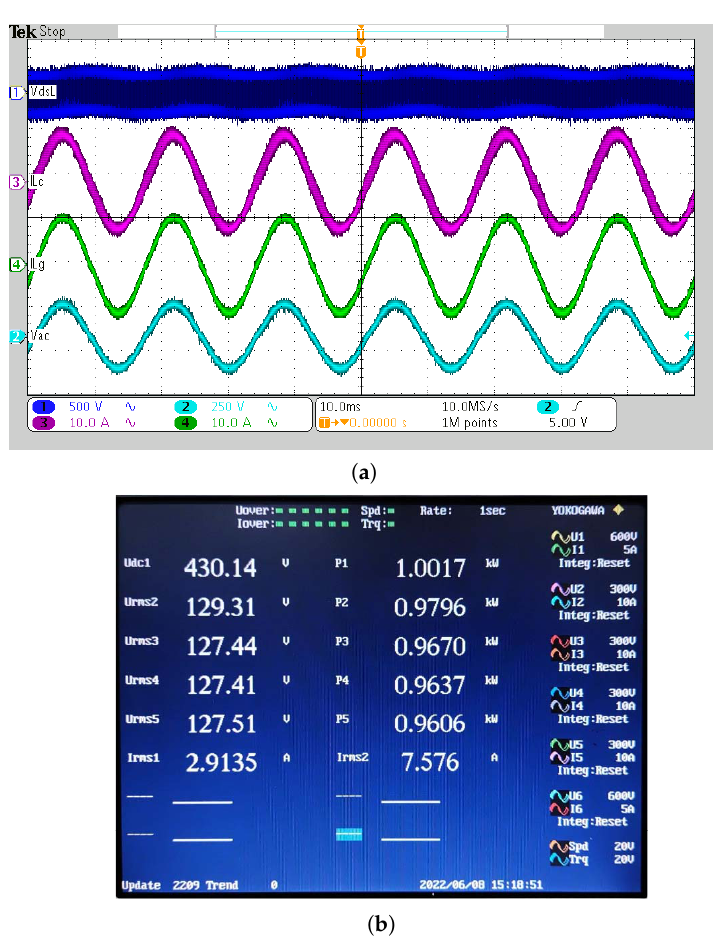
Figure 12. Measurements. ( a ) Oscilloscope. ( b ) Power